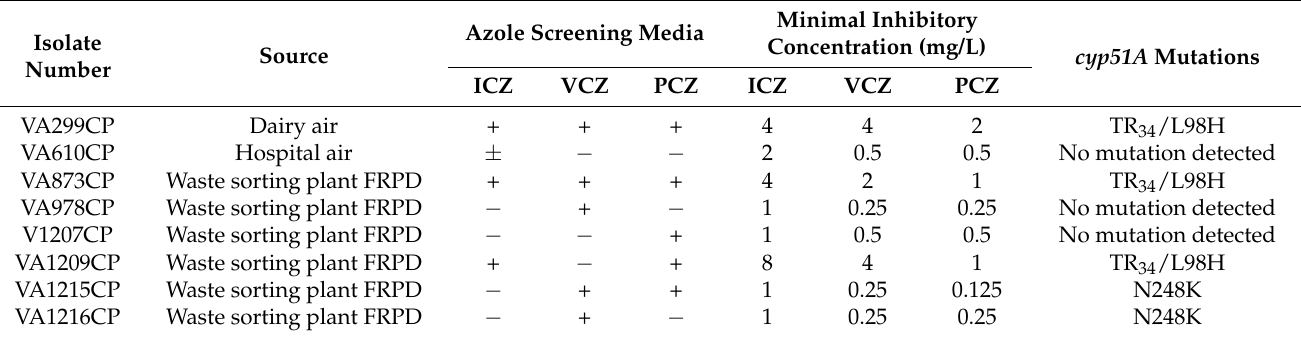
Table 3. Growth of resistant A. fumigatus isolates in different screening media, minimal inhibitory concentrations for ICZ, VCZ and PCZ, and mutations found on the cyp51A gene and its